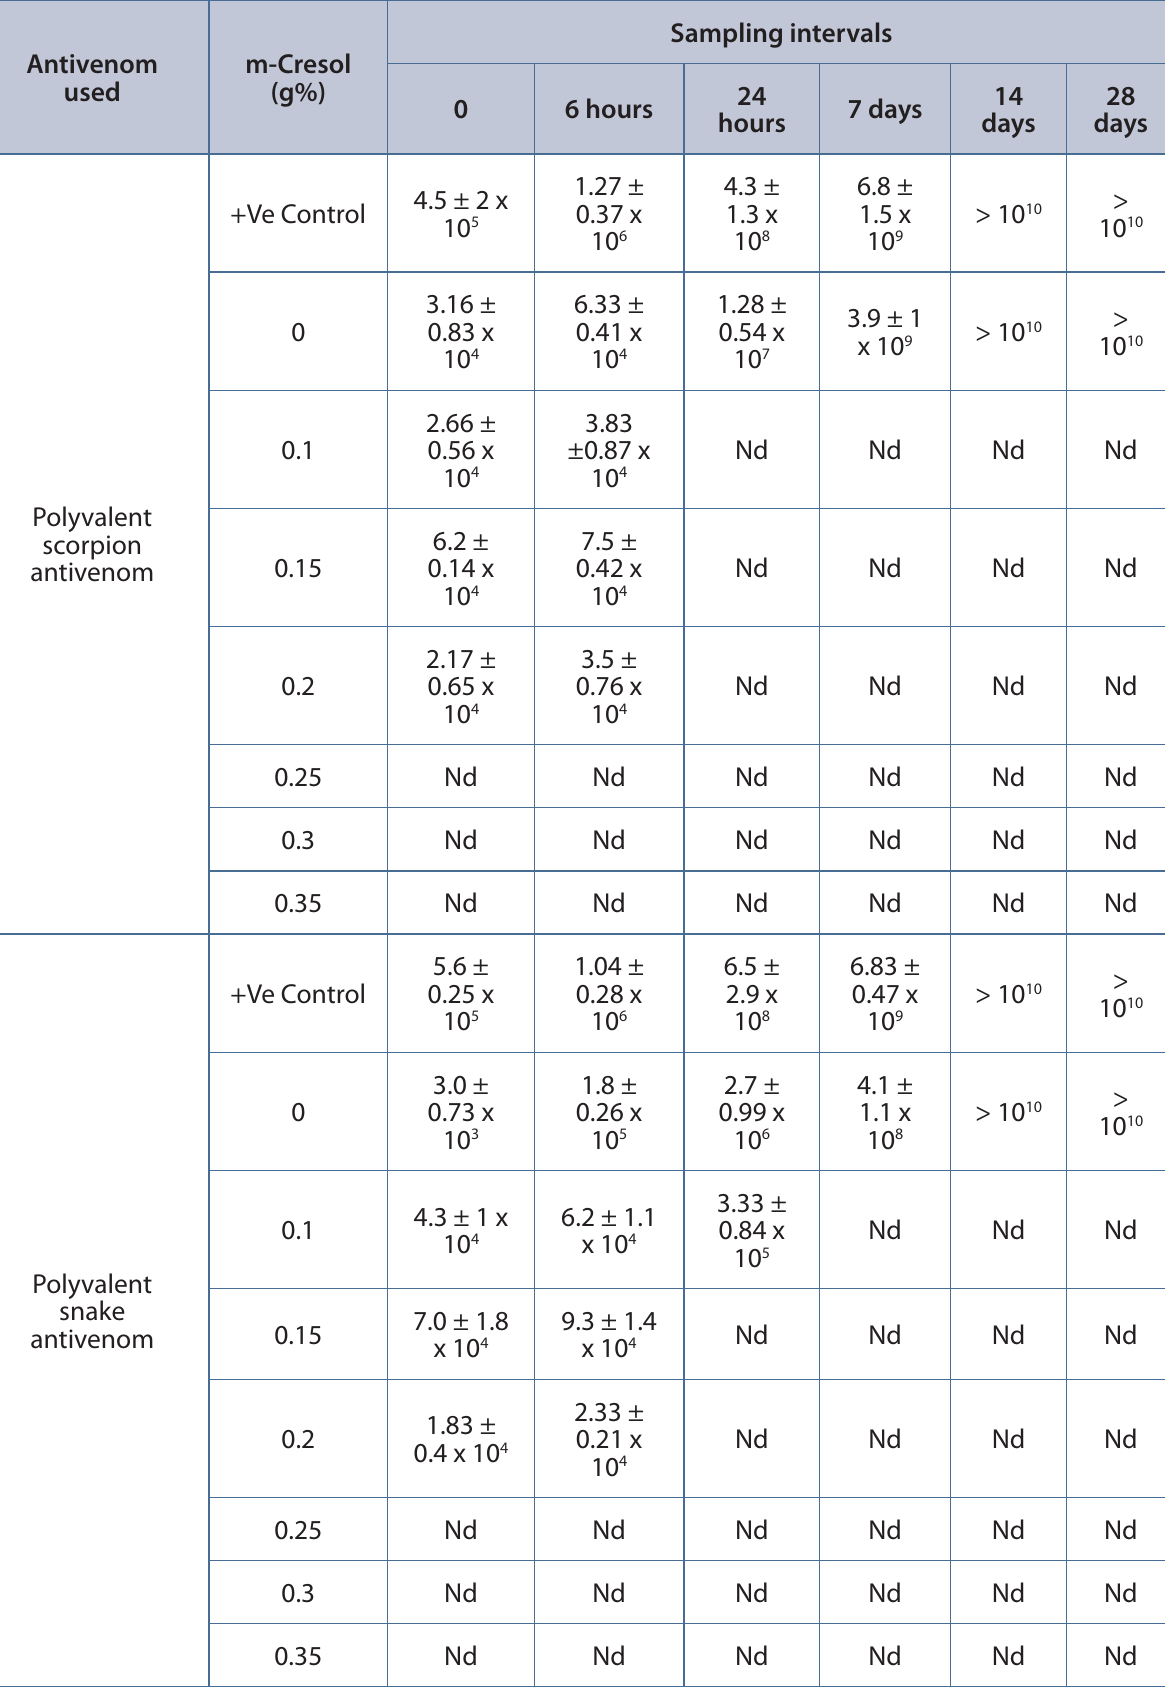
Values represent the mean of six samples followed by their respective standard error of the mean. CFU: colony-forming unit; Nd: not